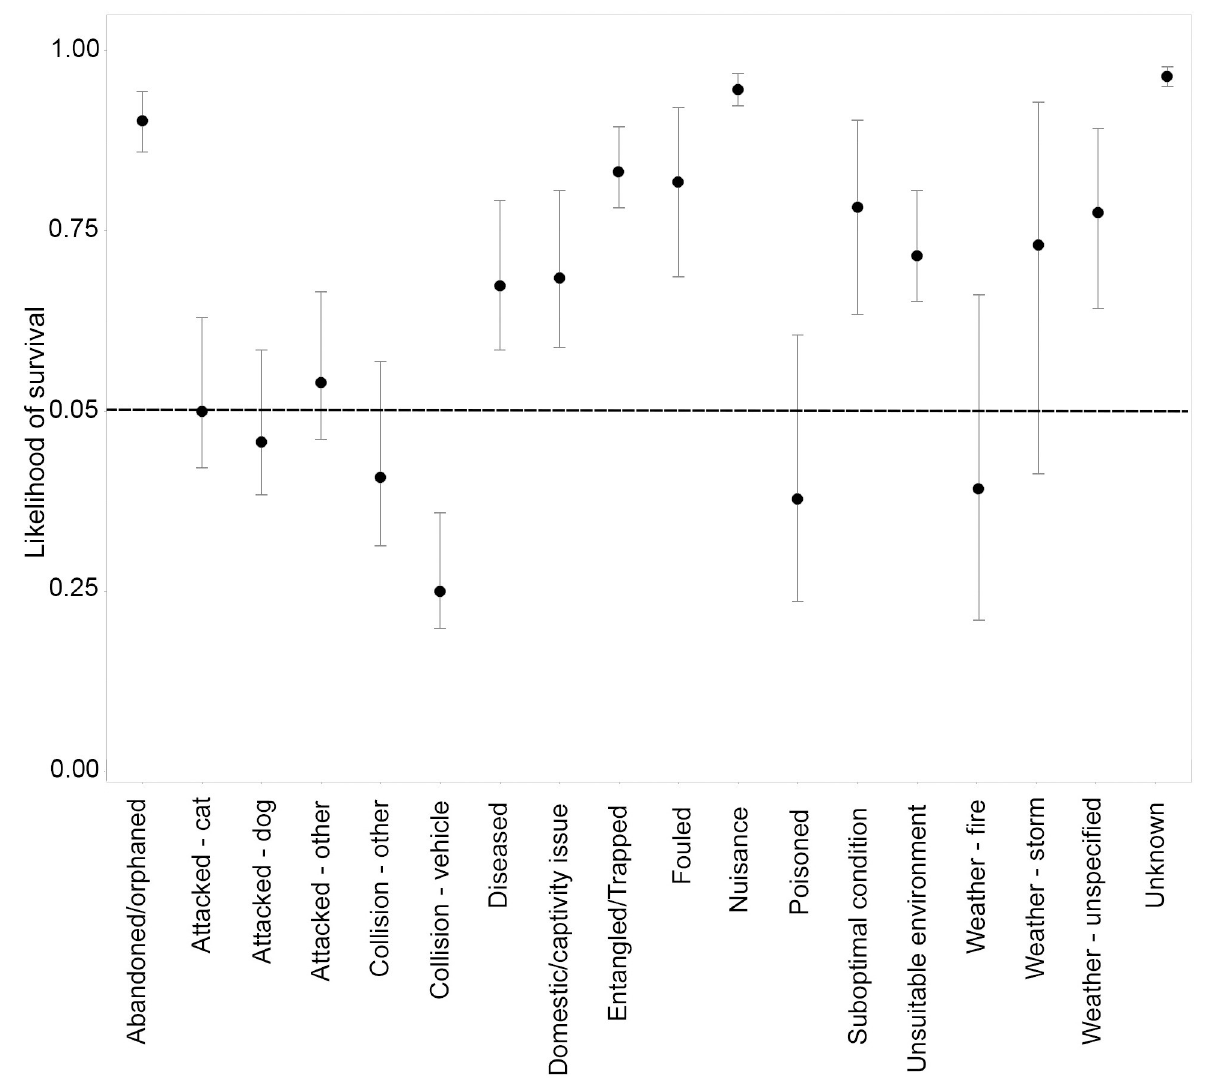
Fig 13. Likelihood of survival + 95% confidence intervals for reptiles in relation to cause for